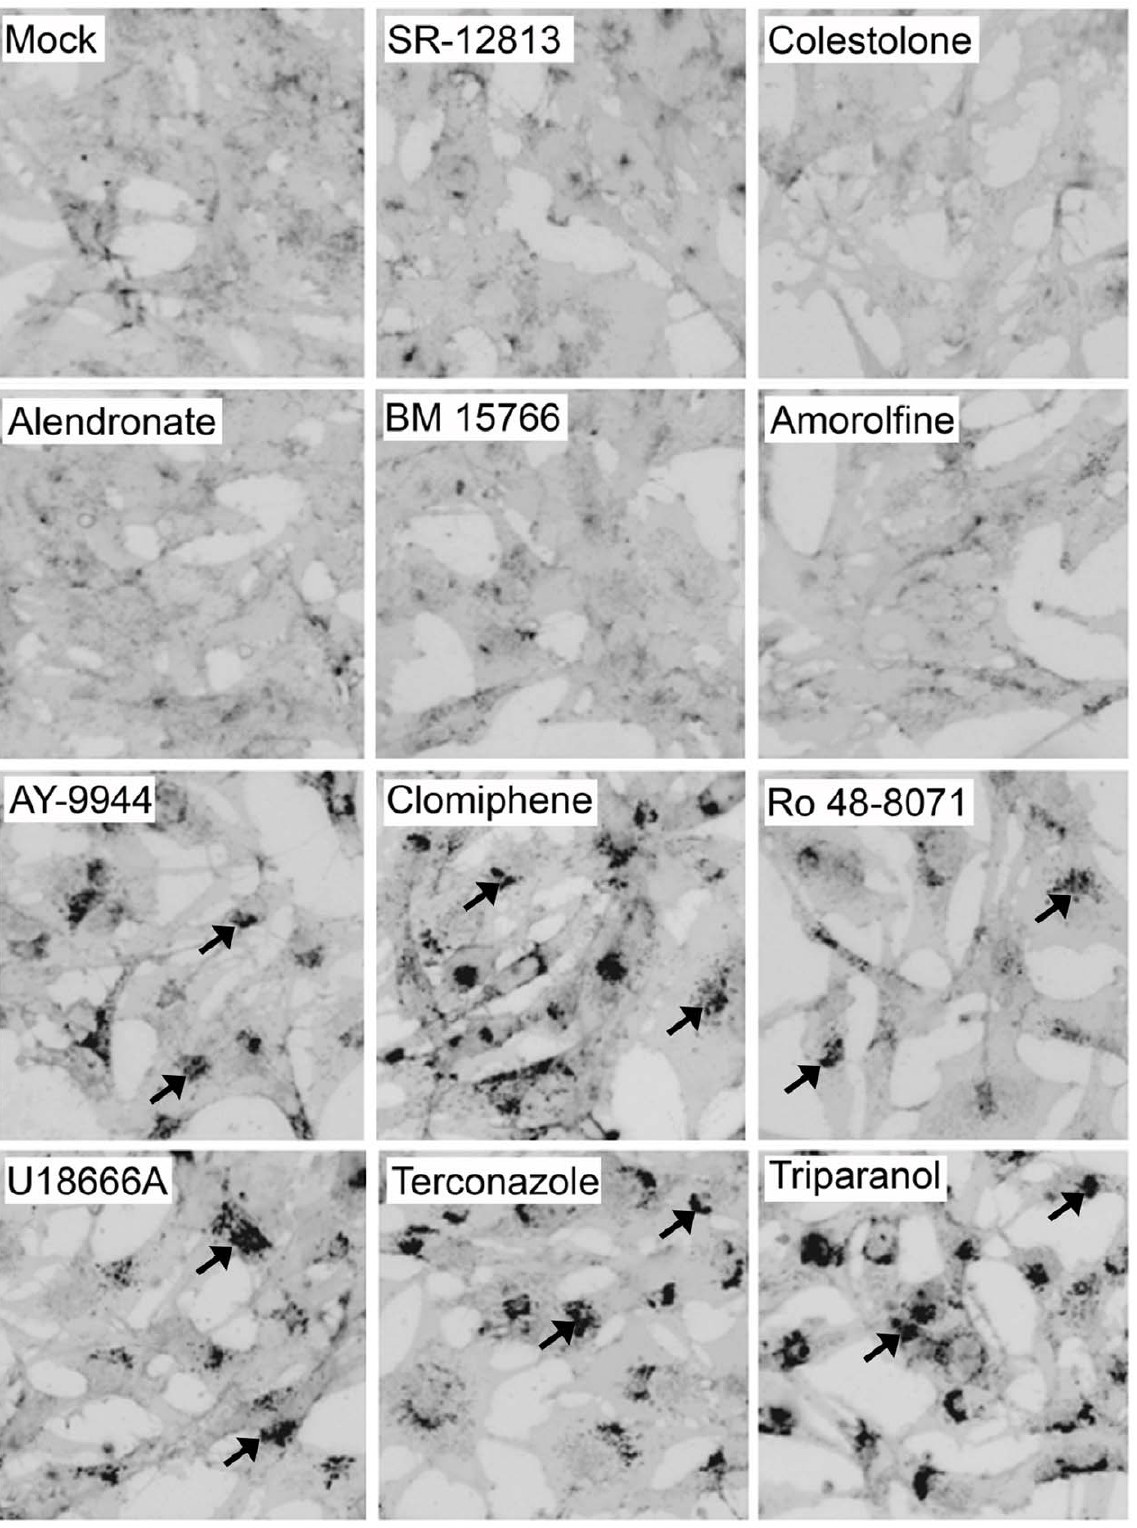
Figure 5. CADs that strongly inhibit EBOV entry and infection cause cholesterol accumulation in LE/Lys. SNB19 cells were treated for 21 hr with either DMSO or inhibitor (concentrations as in Fig. 2). Cells were then fixed, stained with filipin, and imaged on a fluorescence microscope. Images were inverted and uniformly adjusted for contrast and brightness. Representative images are shown. Arrows indicate sites of cholesterol accumulation. Each compound was tested at least 3 times, and scored ( + / 2 ) by a blind observer (Table 1).